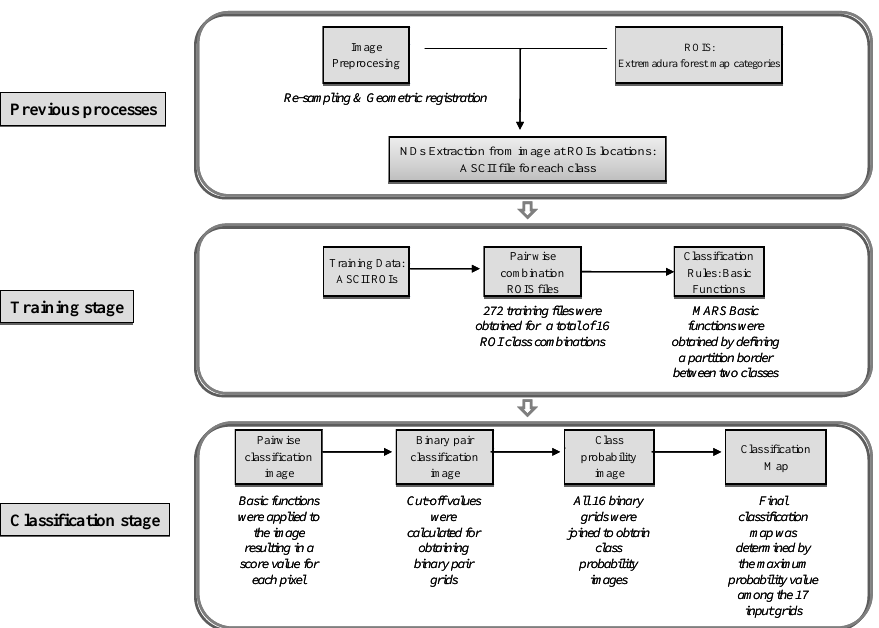
Figure 4. Work flow for the MARS process classification. Image Preprocesing Re-sampling&